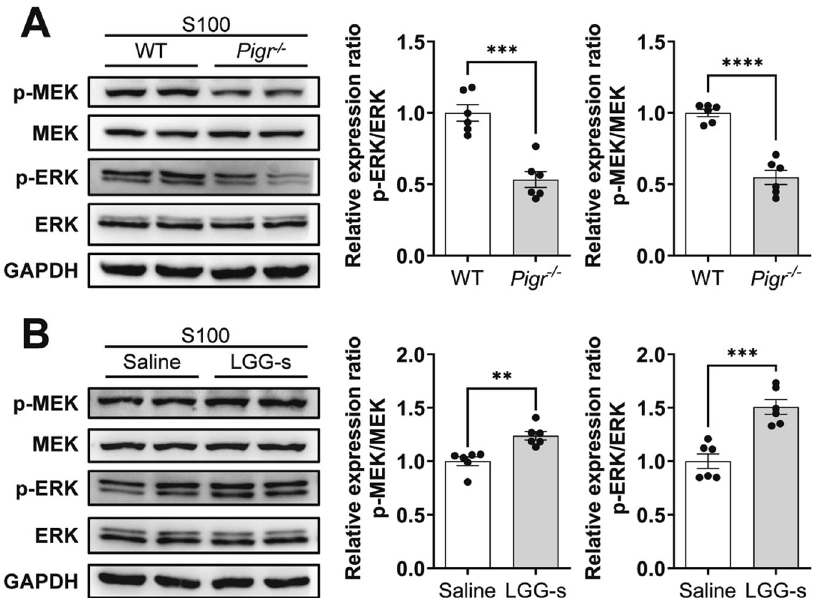
Fig. 6 Effects of Pigr deletion and LGG-s on intestinal MEK/ERK phosphorylation. Western blotting analysis for the p-MEK and p-ERK normalized by MEK and ERK. A Pigr − / − inhibits intestinal MEK/ERK phosphorylation and ( B ) LGG-s promotes intestinal MEK/ERK phosphorylation. Data are presented as mean ± SEM. Statistical analysis was performed using Student ’ s t